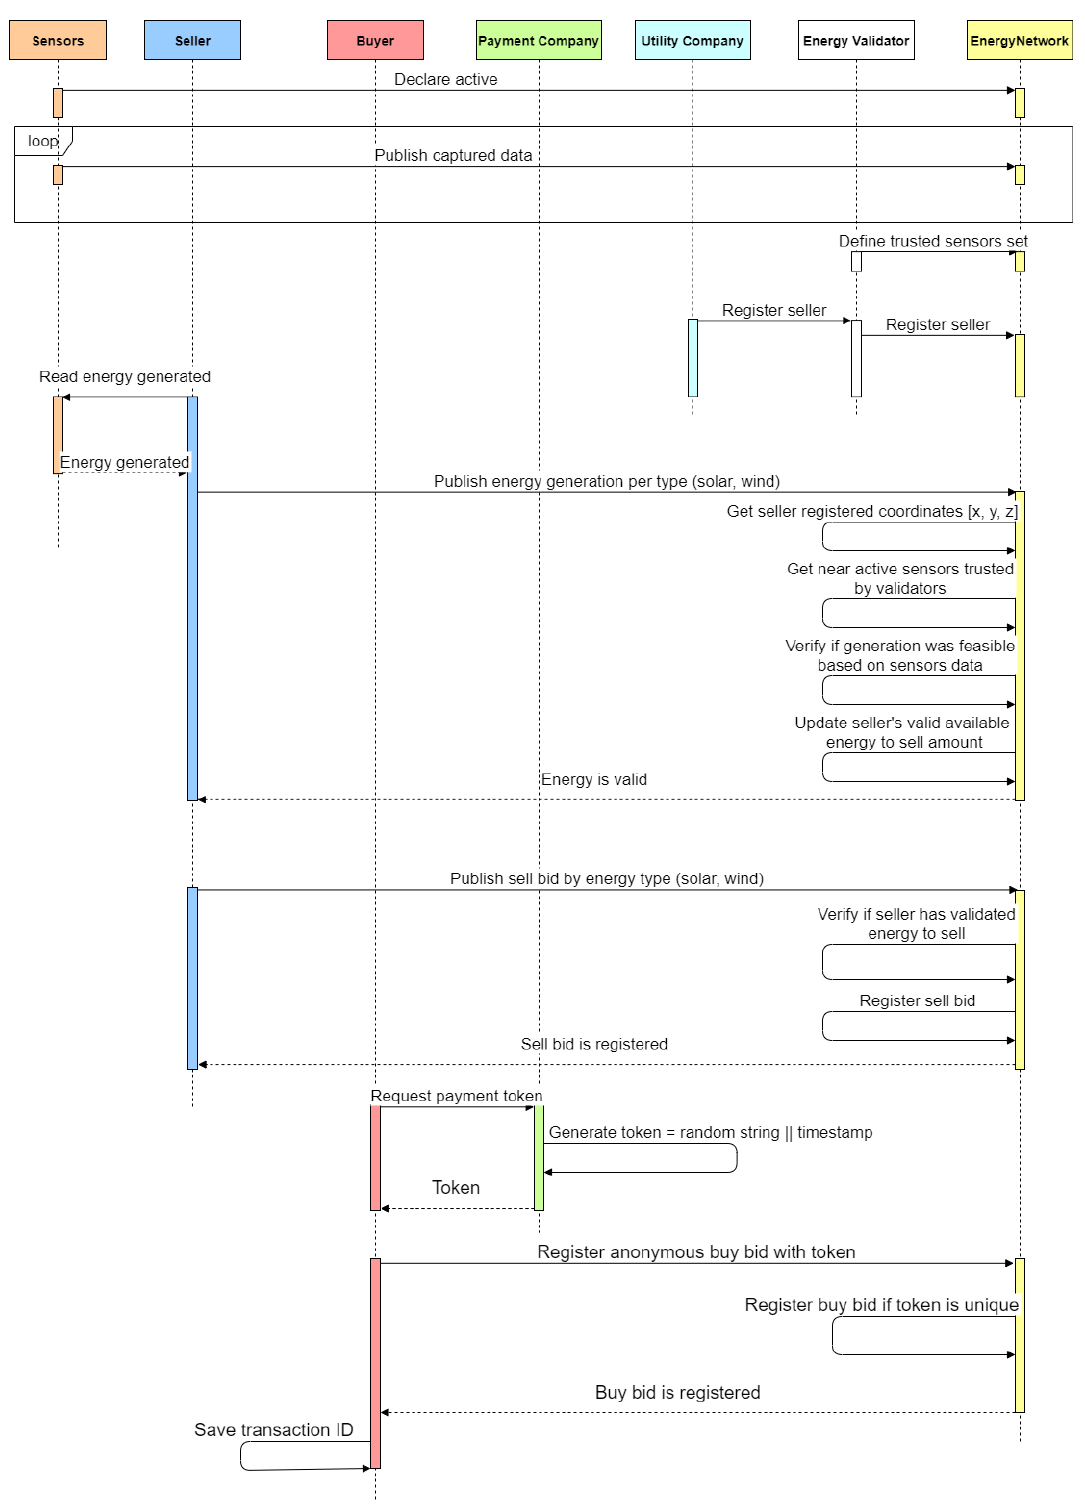
Figure 3. Sequence